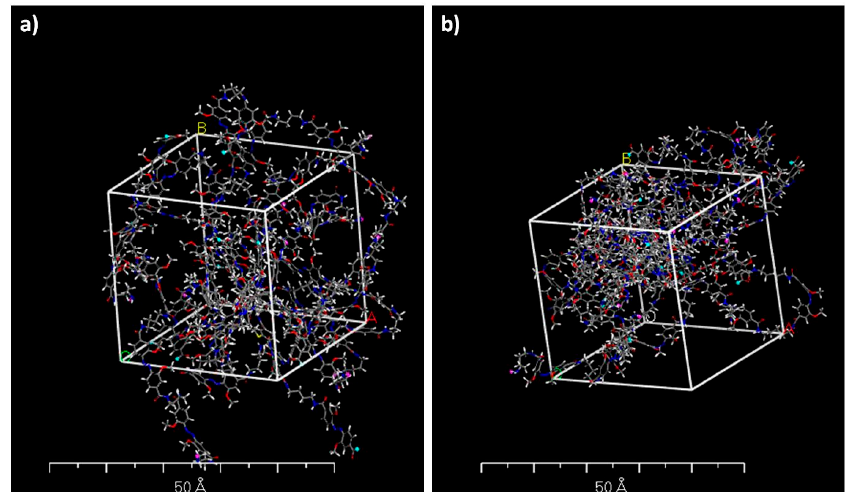
Figure 7. 3-D structures of the simplified microcapsule formed with azo and DAB units between neighboring cross-linker molecules, before ( a ) and after ( b ) irradiation.